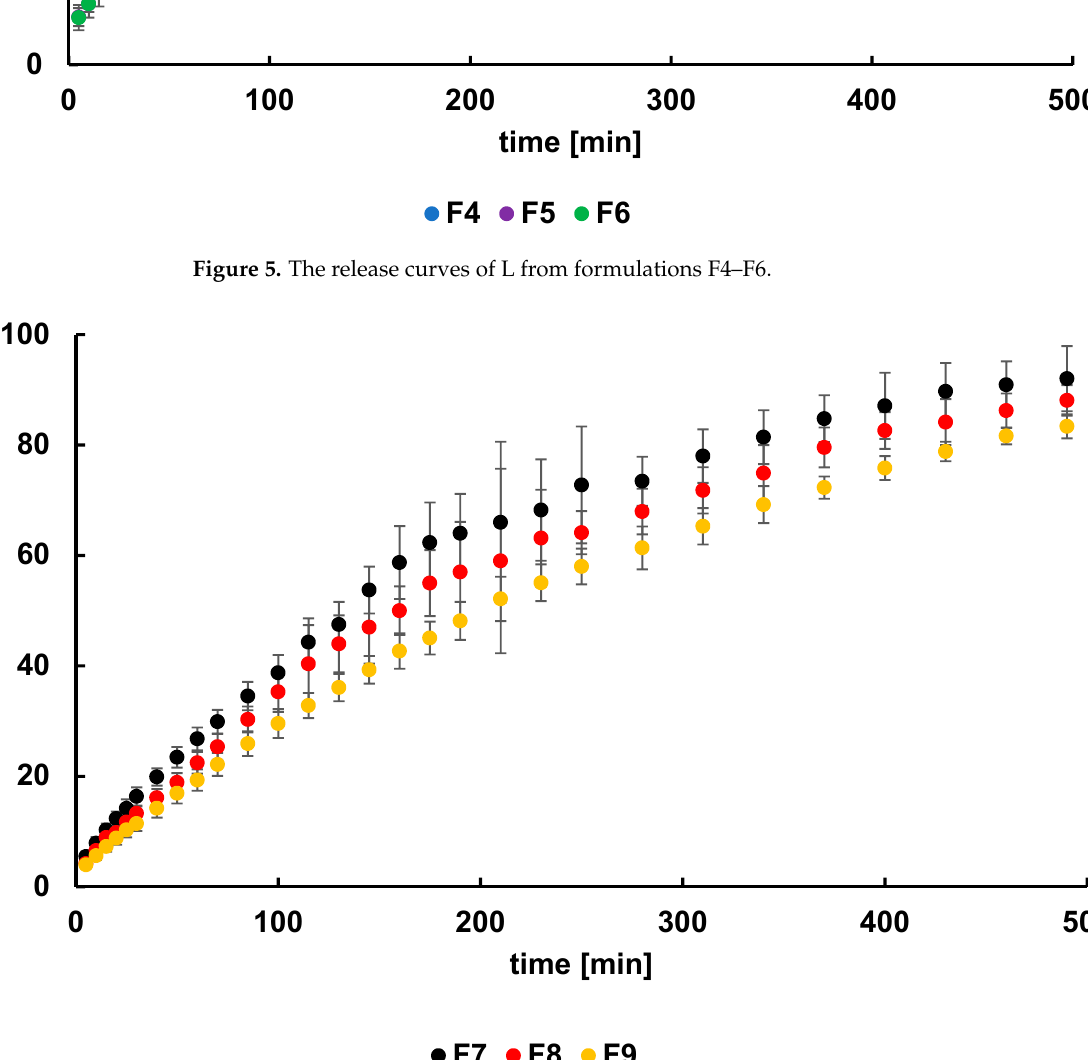
Figure 6. The release curves of N from formulations F7–F9.